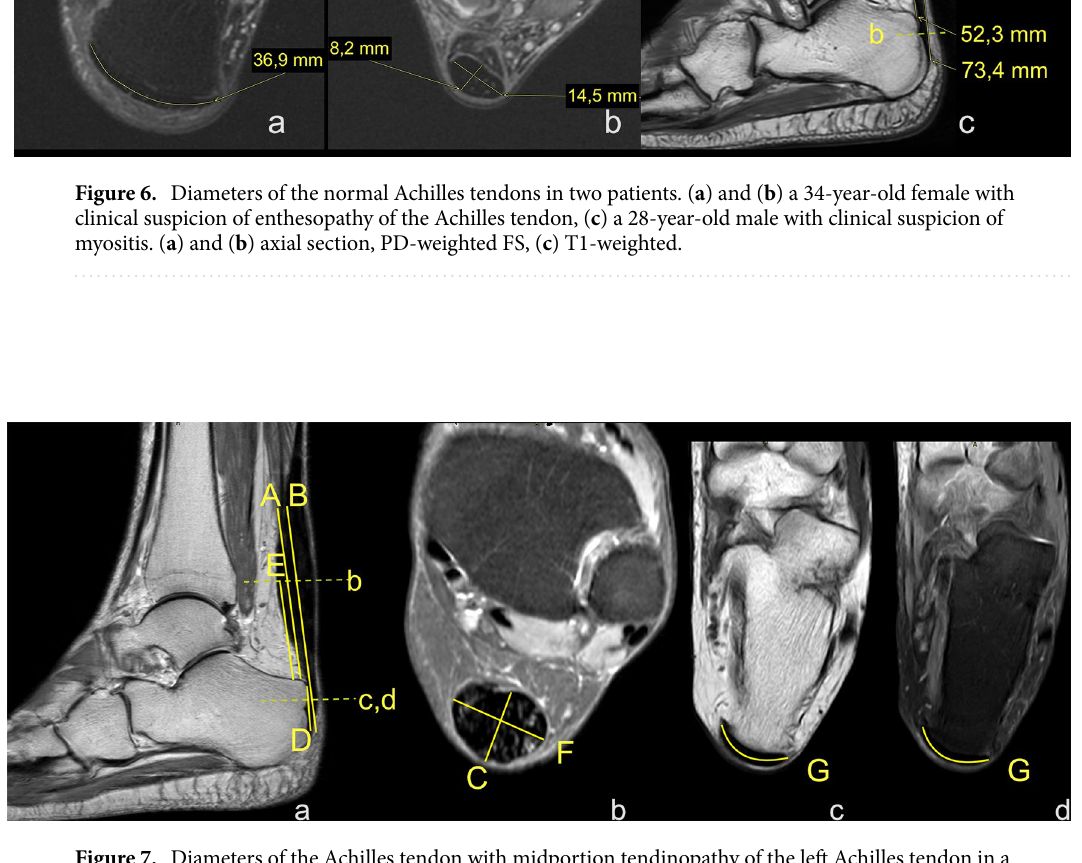
Figure 7. Diameters of the Achilles tendon with midportion tendinopathy of the left Achilles tendon in a 52-year-old male who presented with Achilles pain. Clinical suspicion of tendinopathy with partial rupture. MRI showed an advanced tendinopathy. A, B, C, D, F, G—dimensions of the Achilles tendon; definitions in the Material and Methods. ( a ) sagittal section PD- weighted, ( b ) PD- axial section weighted FS, ( c ) axial section T1- weighted, ( d ) axial section PD- weighted